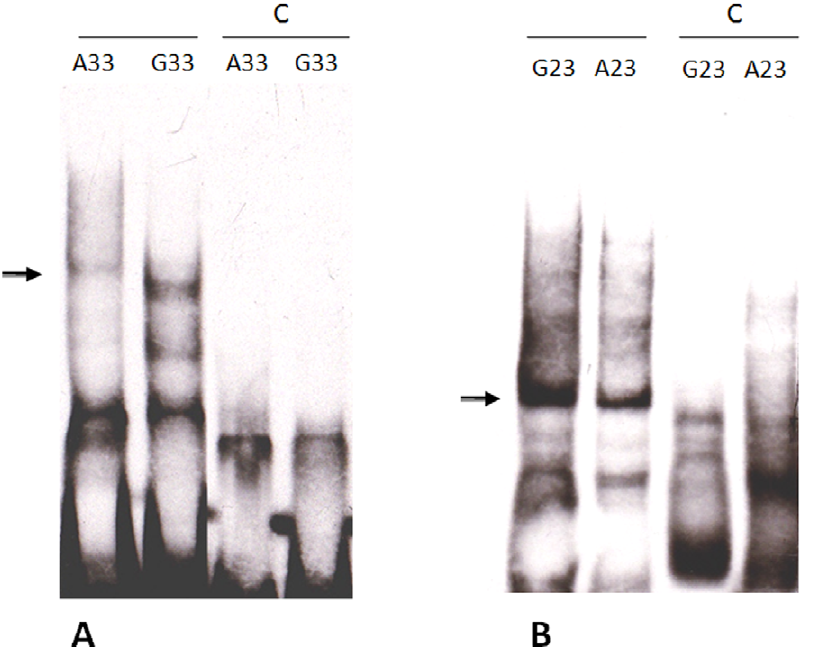
Figure 5. EMSA results of comparison of the binding affinities of biotinylated oligonucleotides. (A) Lanes 1 and 2 indicating the mobilities of labeled, biotinylated oligonucleotides (A33 and G33) with nuclear extracts. A stronger shift was observed in the G33 in comparison to the A33 oligonucleotide. Lanes 3 and 4 showing the competition experiments. The unlabeled oligonucleotides completely inhibited the specific binding complex of biotin-labeled A33 and G33 probes to nuclear extract. (B) Lanes 1 and 2 indicating the mobilities of labeled oligonucleotides (G23 and A23) with nuclear extracts. A stronger binding complex was observed in G23 in comparison with the A23 oligonucleotide. The unlabeled oligonucleotides completely inhibited the specific binding complex of biotin-labeled G23 and A23 probes to nuclear extract in lane 3 and 4. The arrow points to the specific nuclear complex, which binds with the labeled, biotinylated oligonucleotides. C = competitor.